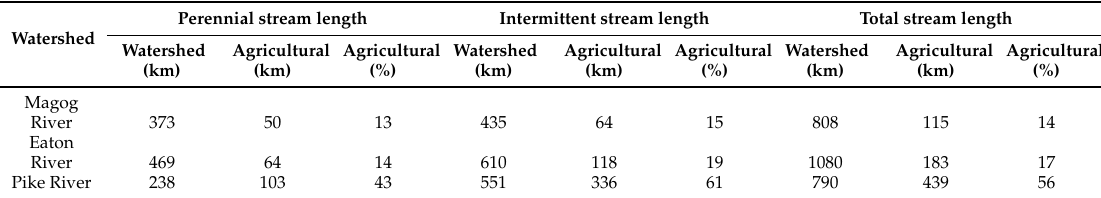
Table 2. Perennial, intermittent and total stream length for the entire watershed and for the agricultural areas (with no riparian forest cover) of three watersheds of Southern